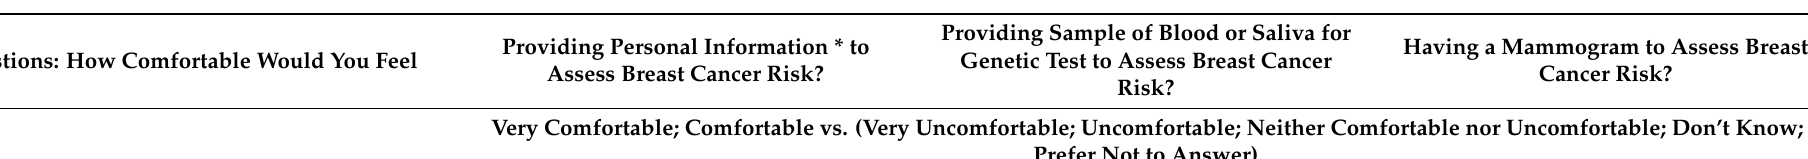
Table 3. Mutually adjusted logistic regression models for the associations between comfort with providing information for breast cancer risk assessment and participants ‘characteristics ( n =